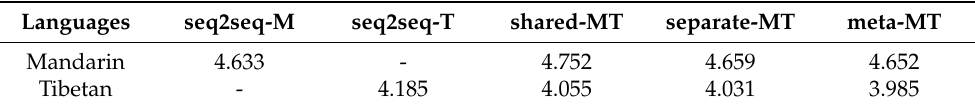
Table 1. The MCD values of different seq2seq TTS models on the test sets. The seq2seq-M and seq2seq- T are Mandarin and Tibetan monolingual TTS models, respectively. The shared-MT, separate-MT, and meta-MT are Mandarin-Tibetan cross-language TTS models.